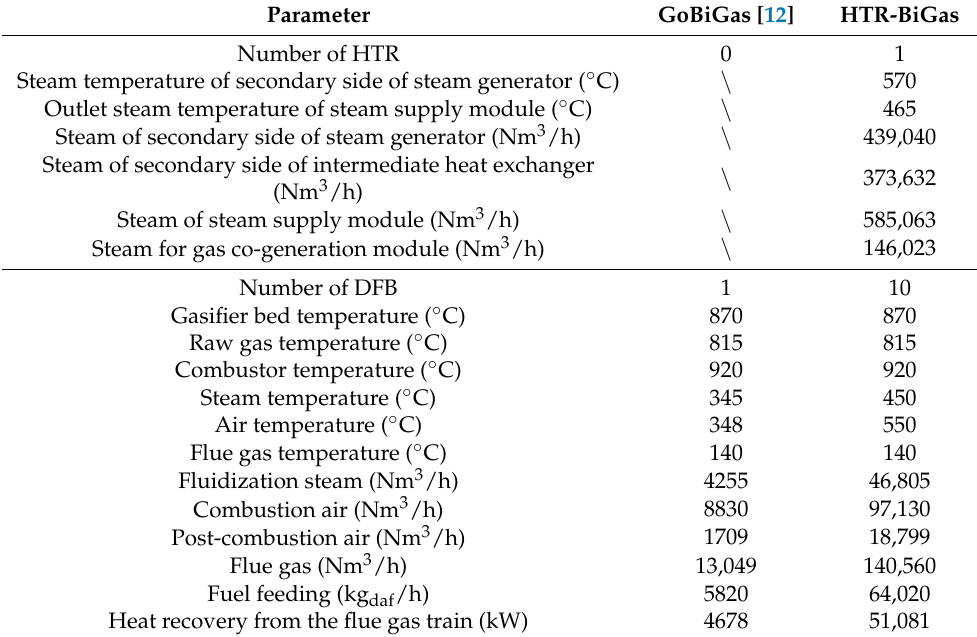
Figure 1. Design of high-temperature gas-cooled reactor biomass gasification (HTR-BiGas): P1. hot raw gas; P2. particle-free gas; P3. cold gas; P4. product gas; P5. flue gas; P6. fuel feed; P7. steam feed; P8. air feed; P9. rapeseed oil methyl (RME); P10. high-pressure gas; P11. sulfur-free gas; P12. rich H 2 gas; P13. CO 2 removal gas; P14. methanation gas; P15. rich CH 4 gas; P16. synthetic natural gas; P17. H 2 . (BTX: benzene, toluene and xylene; WGS: water gas shift; VPSA: vacuum pressure swing adsorption; TSA: temperature swing adsorption). Table 1. Comparison of major design parameters of GoBiGas and HTR-BiGas.